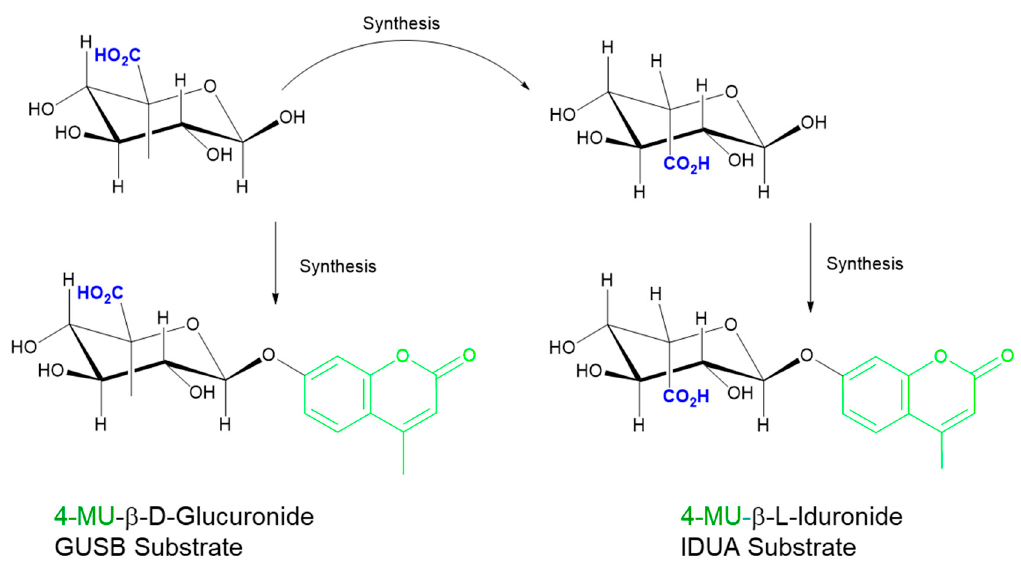
Figure 3. Importance of stereochemistry for specificity. Iduronide (top right) is derived from the stereochemical inversion of the CO 2 H group at C5 in glucuronide (top left). Incomplete inversion leads to glucuronide (GlcA) presence in the iduronide (IdoA) substrates and necessitates the use of